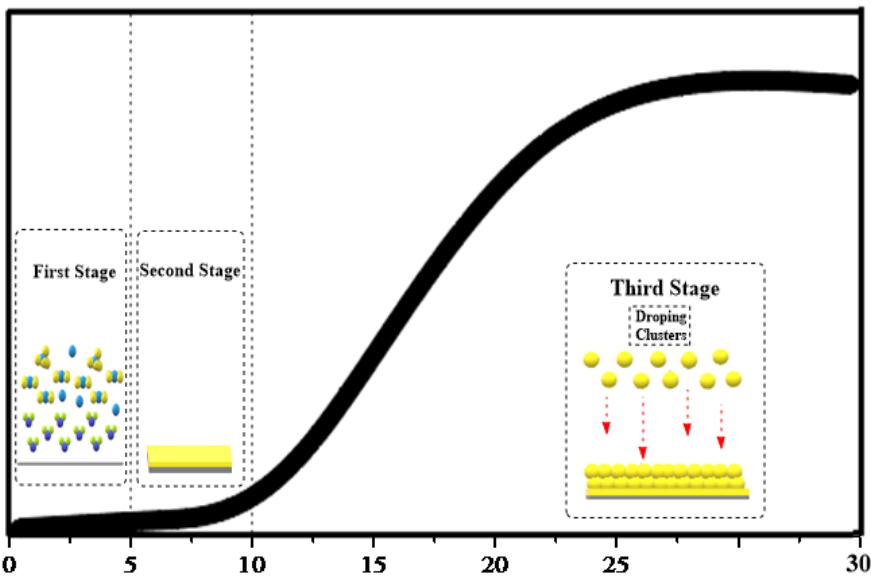
Figure 13. The typical growth curve and growth mechanism of a CBD-based